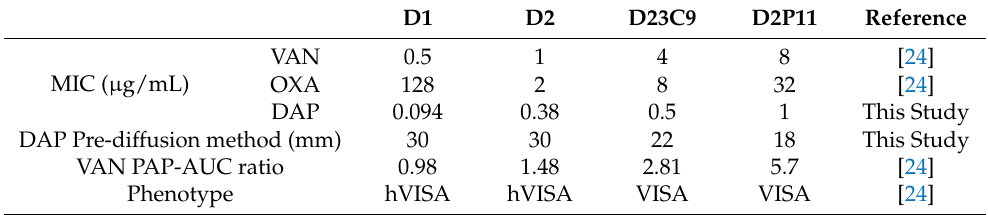
Table 1. Antimicrobial susceptibility profile of the bacterial strains used in this study. MICs (µg/mL), inhibition zone diameter obtained after daptomycin (DAP) pre-diffusion method (mm), and vancomycin (VAN) population analysis profile and area under the curve (PAP-AUC) ratio. The AUC was measured for each sample and the ratio of test isolate AUC/mean Mu3 AUC was calculated. Mu3 was used as hVISA control strain. The criteria to define hVISA and VSSA were a PAP-AUC ratio ≥ 0.90 and a PAP/AUC ratio < 0.90, respectively.